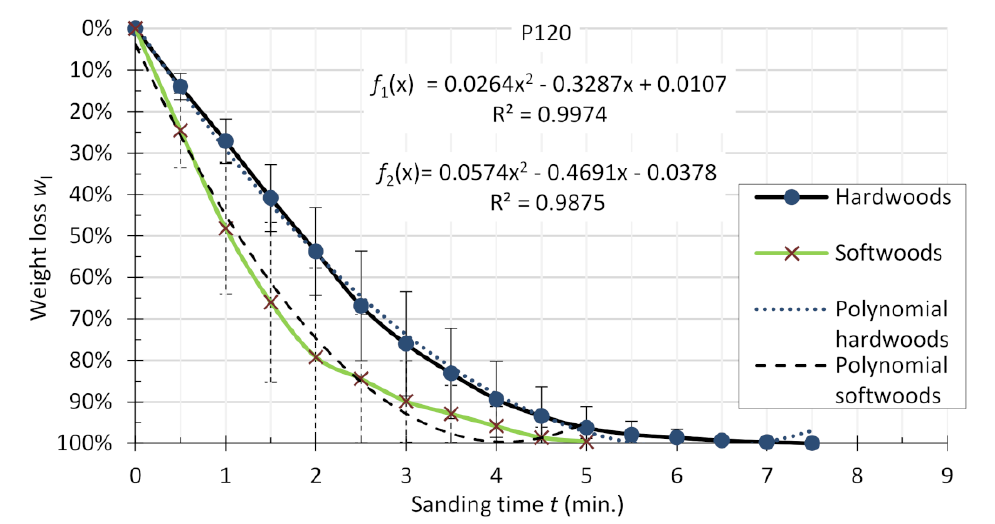
Figure 10. Comparison of average results for hardwoods (beech, oak, ash, hornbeam, alder) and softwoods (pine, spruce, larch) species; P120